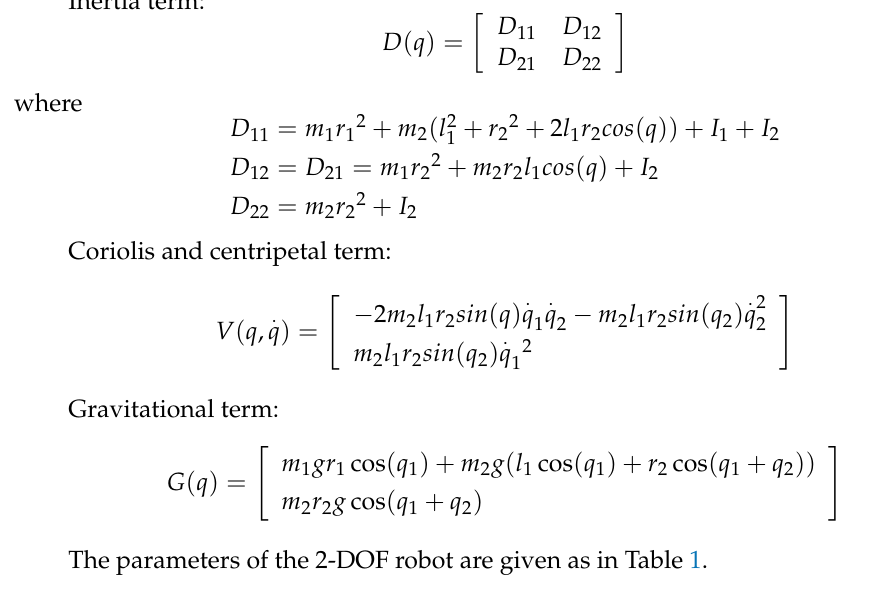
Table 1. Parameters of the 2-link robot